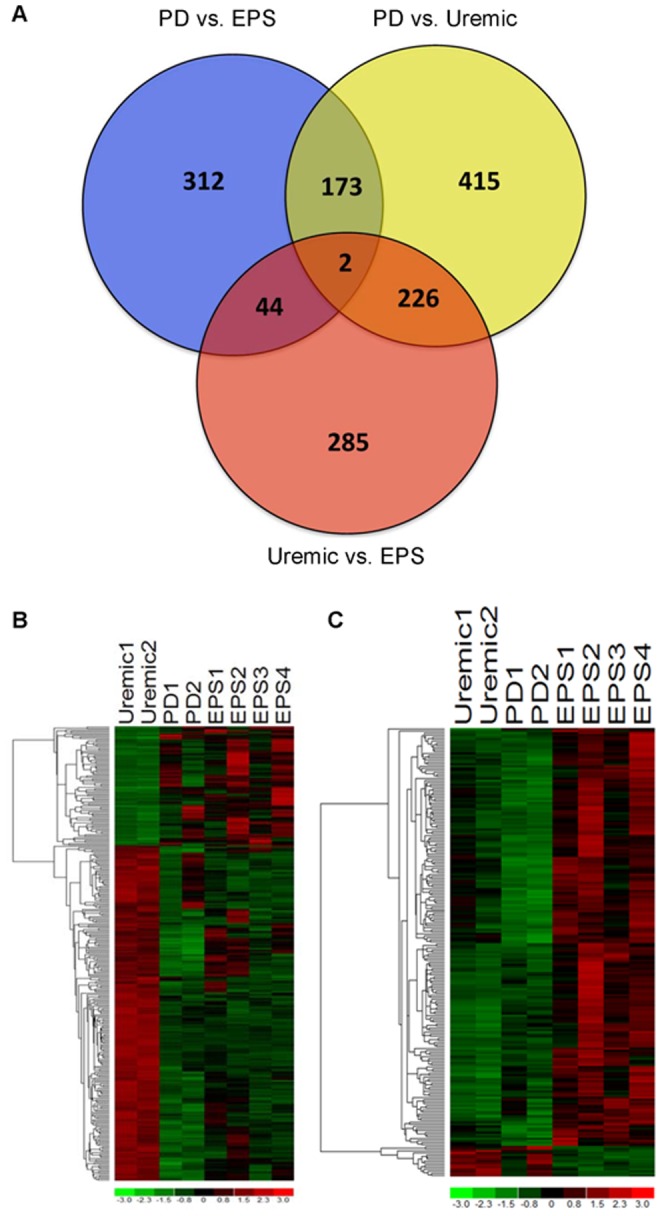
Differentially expressed genes identified from supervised analyses.
A. Venn diagram comparing significantly differentially expressed genes identified from the pairwise comparisons Uremic vs. PD (yellow), PD vs. EPS (blue), and Uremic vs. EPS (red). The genes were selected using supervised analysis on the basis of the 90% lower confidence bound (LCB) of the fold change (FC) by pairwise comparison of the groups. The analysis was performed on preprocessed data by filtering out low-expressing probes on the basis of absolute intensity (Intensity <10 in 90% of samples). B. Heatmap of genes differentially expressed in both EPS and PD groups as compared to Uremic group (P<0.05). C. Heatmap of genes differentially expressed only in EPS as compared to both PD and Uremic groups (P<0.05). Columns represent the samples, with rows representing genes. Gene expression levels are presented in pseudocolor (scale −3 to 3), with red and green respectively denoting high and low expression levels.